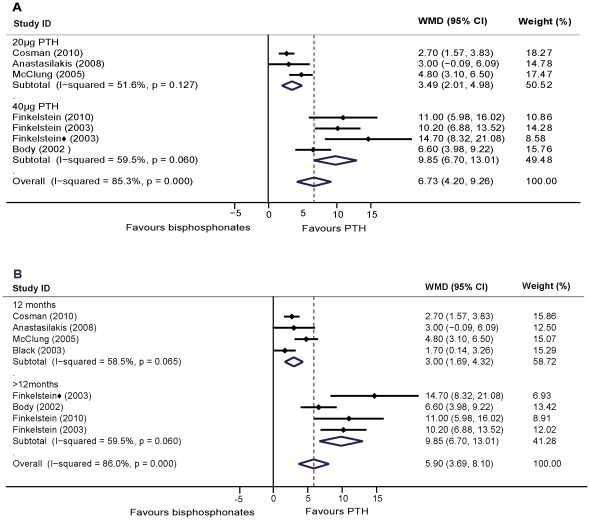
Assessment of the effects of PTH versus bisphosphonates on BMD of the lumbar spine.A: Subgrouped analysis of dosage of PTH (1–34) versus bisphosphonates treatment on spinal BMD. B: Subgrouped analysis of the duration of PTH (1–34) versus bisphosphonates treatment on spinal BMD. ⧫: The study reported BMD data in lateral spine.